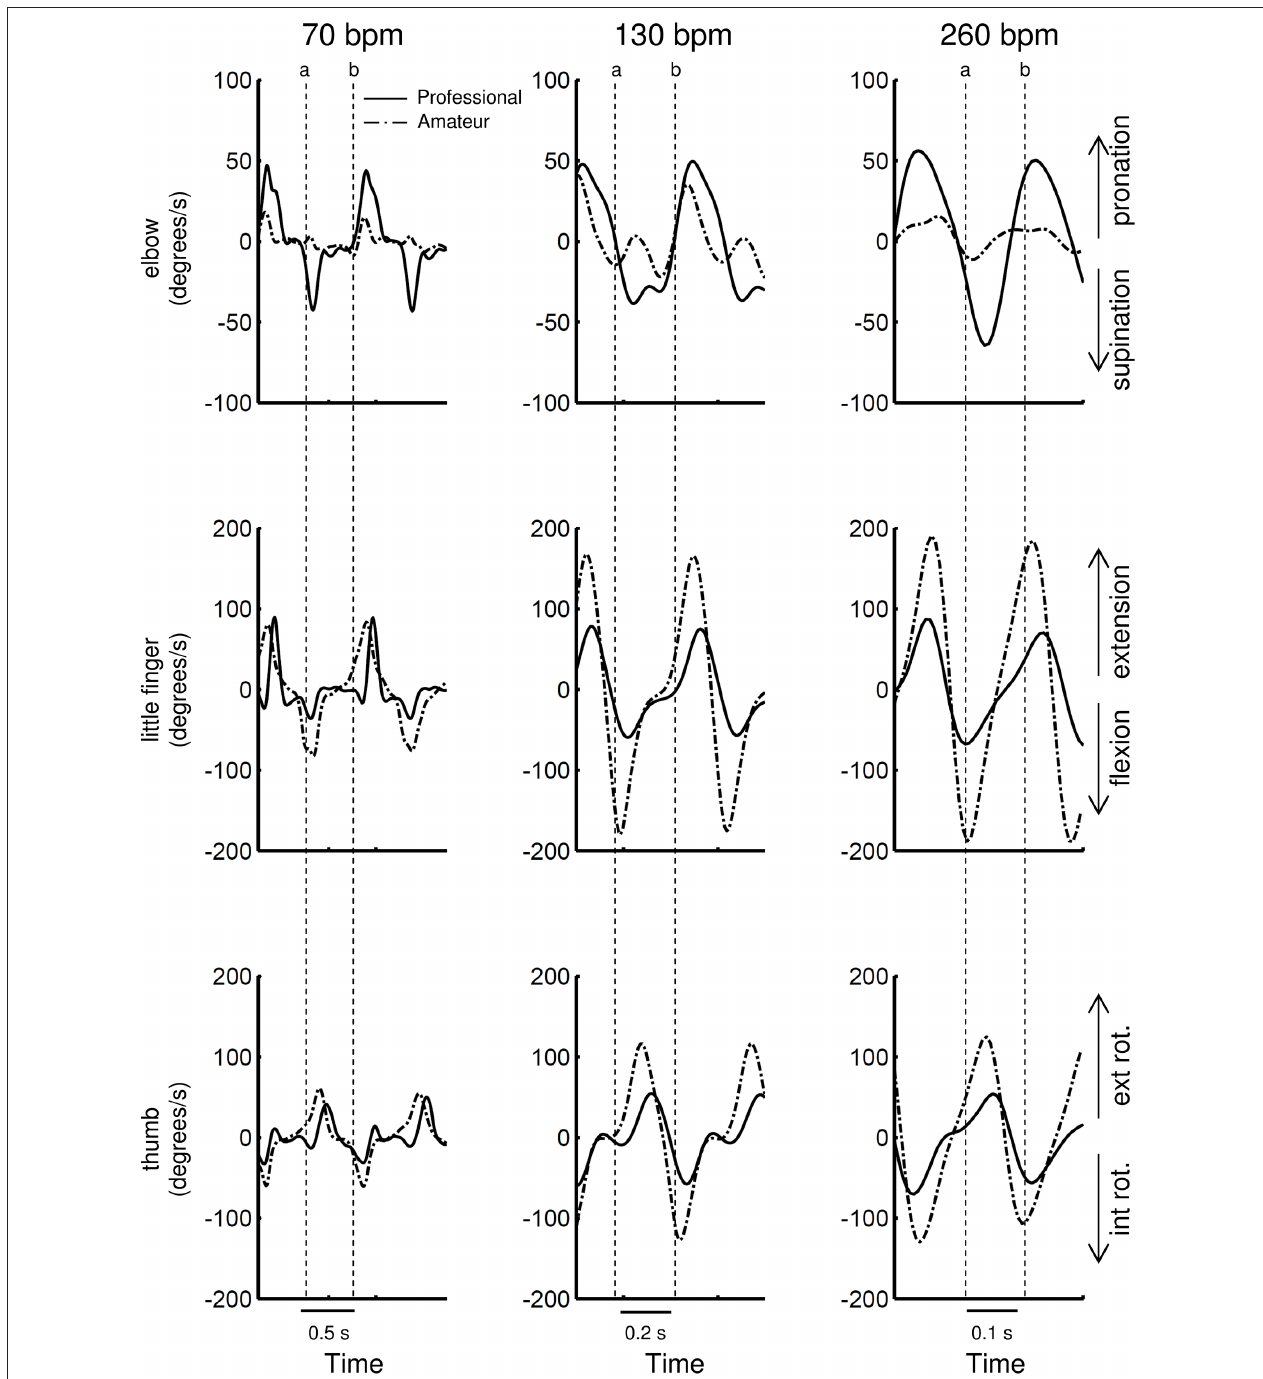
Figure 2 | Time-history curves of the angular velocity for elbow pronation ( + ) and supination ( − ), MCP extension ( + ) and flexion ( − ) at the little finger, and external ( + ) and internal ( − ) rotation at the thumb across different tempi (70, 130, and 260 bpm) for a single trial. The solid and dashed lines represent one representative professional and one representative amateur pianist, respectively. A vertical dotted line denotes the moment when the key contacts the little finger (a) and the thumb (b).